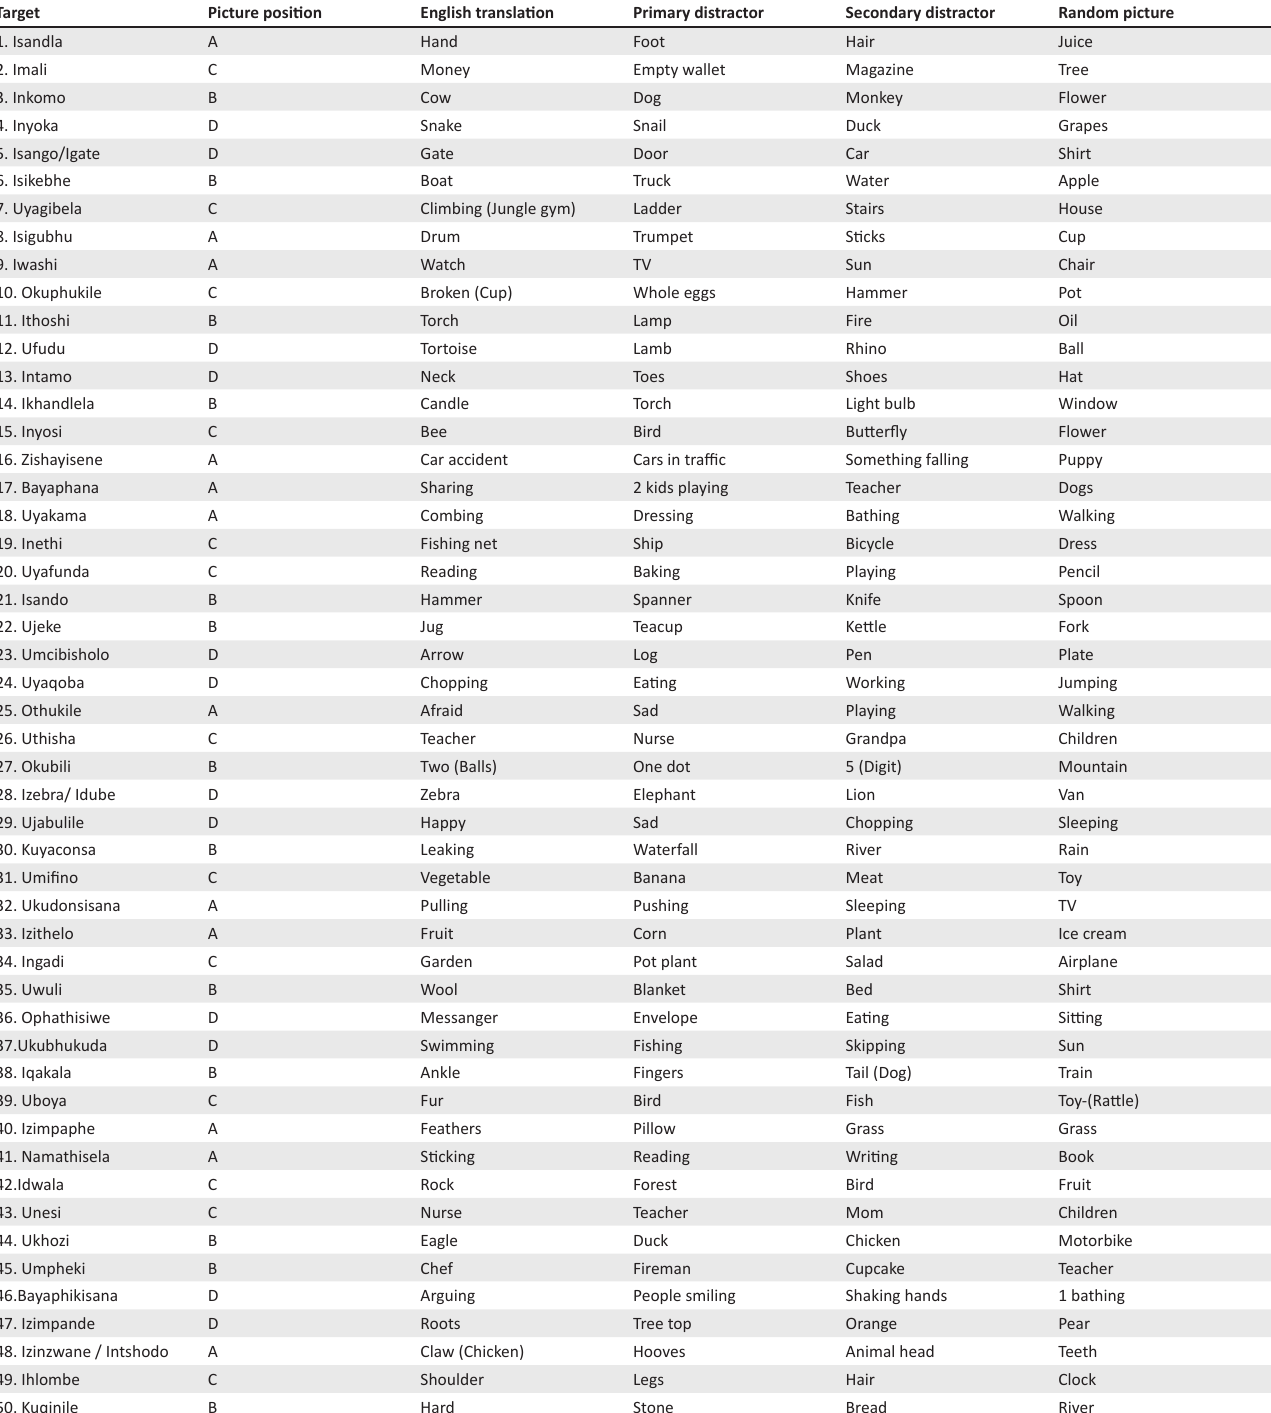
TABLE 1: Ingwavuma receptive vocabulary test target and illustration plan.